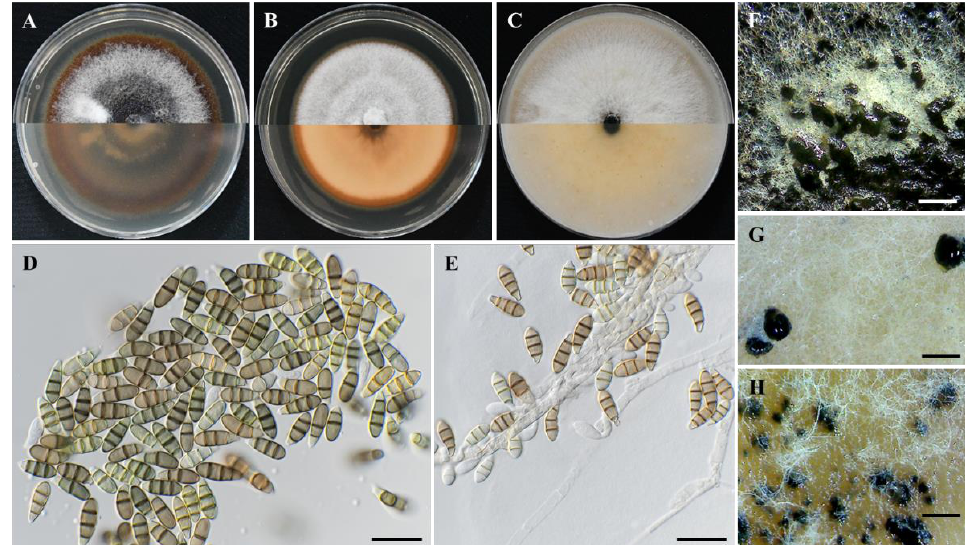
Figure 6. Sporocadus rosigena isolate L106 (CBS 149021). ( A – C ) Colonies cultured on PDA, MEA and OA, respectively, at 25 °C in the dark for 14 days (top: above and bottom: reverse). ( D ) Septate conidia lacking appendages. ( E ) Conidiophores, conidiogenous cells and conidia. ( F – H ) Conidiomata on PDA, OA, and MEA, respectively. Scale bars: 20 μm ( D , F ) and 500 μm ( F – H ). Colony of Spo. rosigena isolate L106 (CBS 149021) on PDA fast-growing, flat, dark mouse gray to light sepia with smooth margin, reaching 58.25 mm in diameter after 14 days at 25 °C in darkness, conidiomata black, acervular, gregarious or confluent, erumpent. Colony on MEA fast-growing, slightly raised, wooly, grayish-white with smooth dark sienna margin, reaching in 62.25 mm in diameter after 14 days at 25 °C in darkness, conidiomata black, gregarious or confluent. Colony on OA, fast-growing, slightly raised, wooly, white with smooth olivaceous buff margin, reaching 78.75 mm diameter after 14 days at 25 °C in darkness.